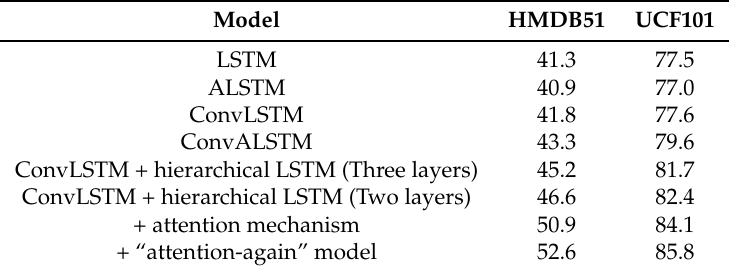
Table 2. Performance of LSTM variants and different components on first split of HMDB51 and UCF101. Classification accuracy is used as evaluation measure which represented as recognition accuracies